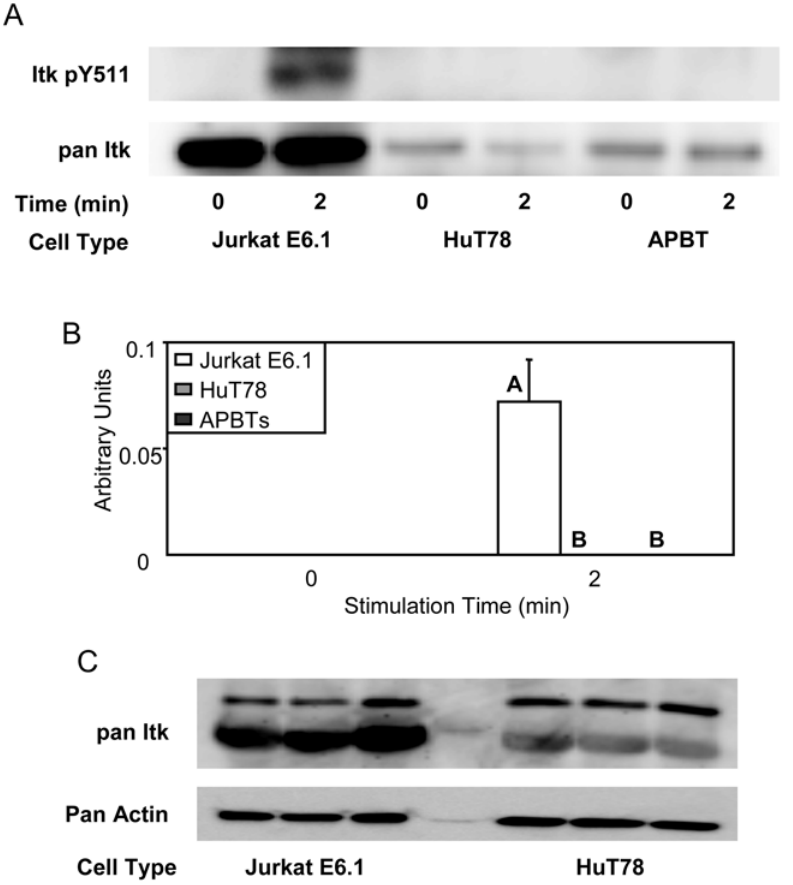
Figure 9. Jurkat E6.1 T cells have increased expression and TCR-induced phosphorylation of Itk compared to HuT78 T cells and APBTs. (A) Itk was immunoprecipitated from lysates for TCR-induced Jurkat E6.1 T cells, HuT78 T cells, and APBTs and the cellular proteins were separated by SDS-PAGE. The site-specific phosphorylation and expression of Itk was assessed by immunoblotting using Itk pY511 (top) and pan-Itk (bottom) antibodies. (B) The immunoblots were analyzed by densitometry and the ratio of the intensity of the phosphospecific Itk band to the pan-Itk band for each cell line for three separate experiments was averaged. Letters represents significant differences of p , 0.04. (C) Whole cell lysates of Jurkat E6.1 T cells and HuT78 T cells were prepared and immunoblotted using pan-Itk (top) and actin (bottom)